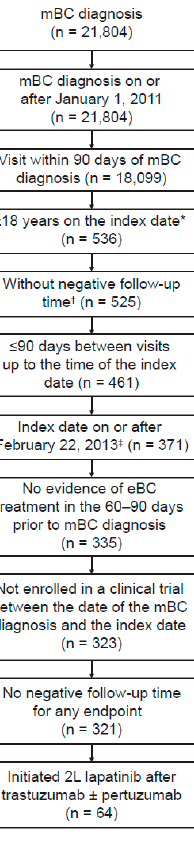
Figure A2. Patient flow diagram for patients initiating lapatinib following 1L trastuzumab. * Date on or prior to 31 December 2019 that treatment with lapatinib was initiated. † Death prior to the mBC diagnosis date. ‡ Date T-DM1 was approved by the US Food and Drug Administration. 1L = first line; 2L = second line; eBC = early breast cancer; mBC = metastatic breast cancer; pts = patients.